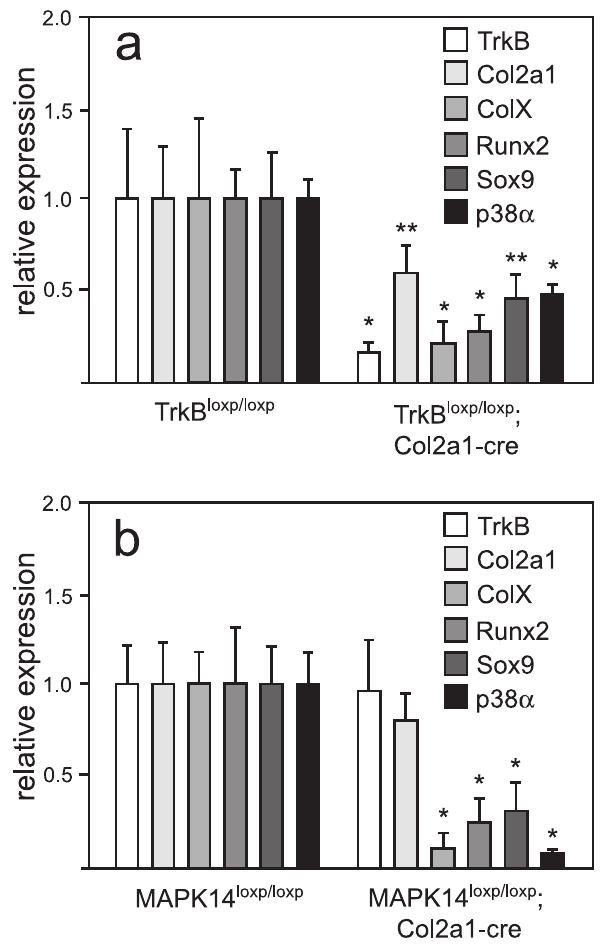
Figure 8. Histological analysis of TrkB mutants for phospho- p38. A, B, are stained histological sections from a 4 week old male TrkB loxp/loxp control; C, D are from a male TrkB loxp/loxp ;Col2a1-cre littermate. A, C, H&E staining; B, D, phospho-p38